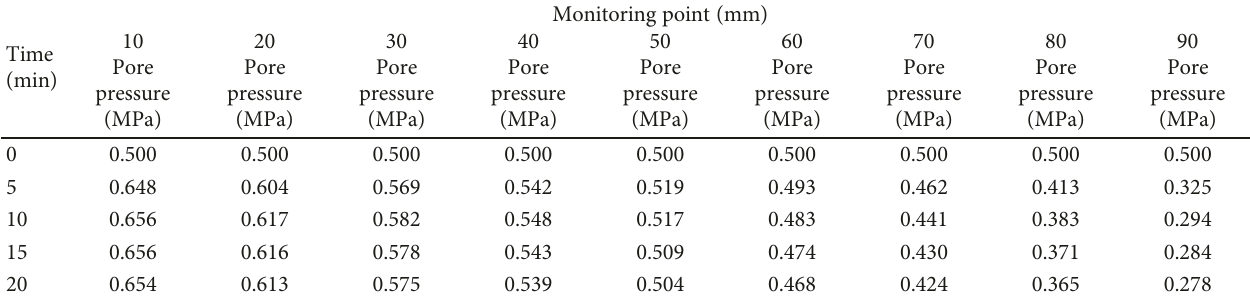
Table 3: Space-time distribution of the pore pressure at the axial monitoring